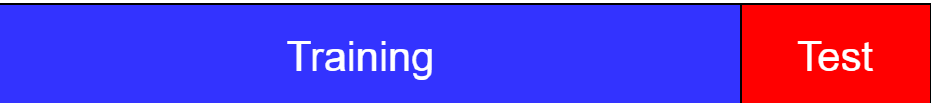
Figure 3. Illustration of training and test data split of time-series